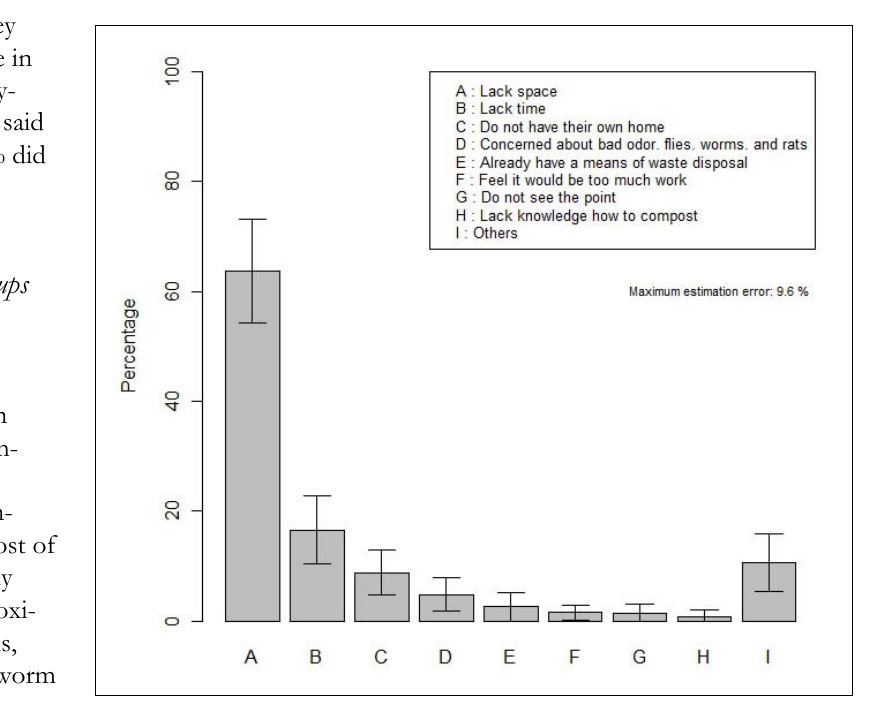
Figure 7. Reasons Some Respondents Are Not Willing To Compost